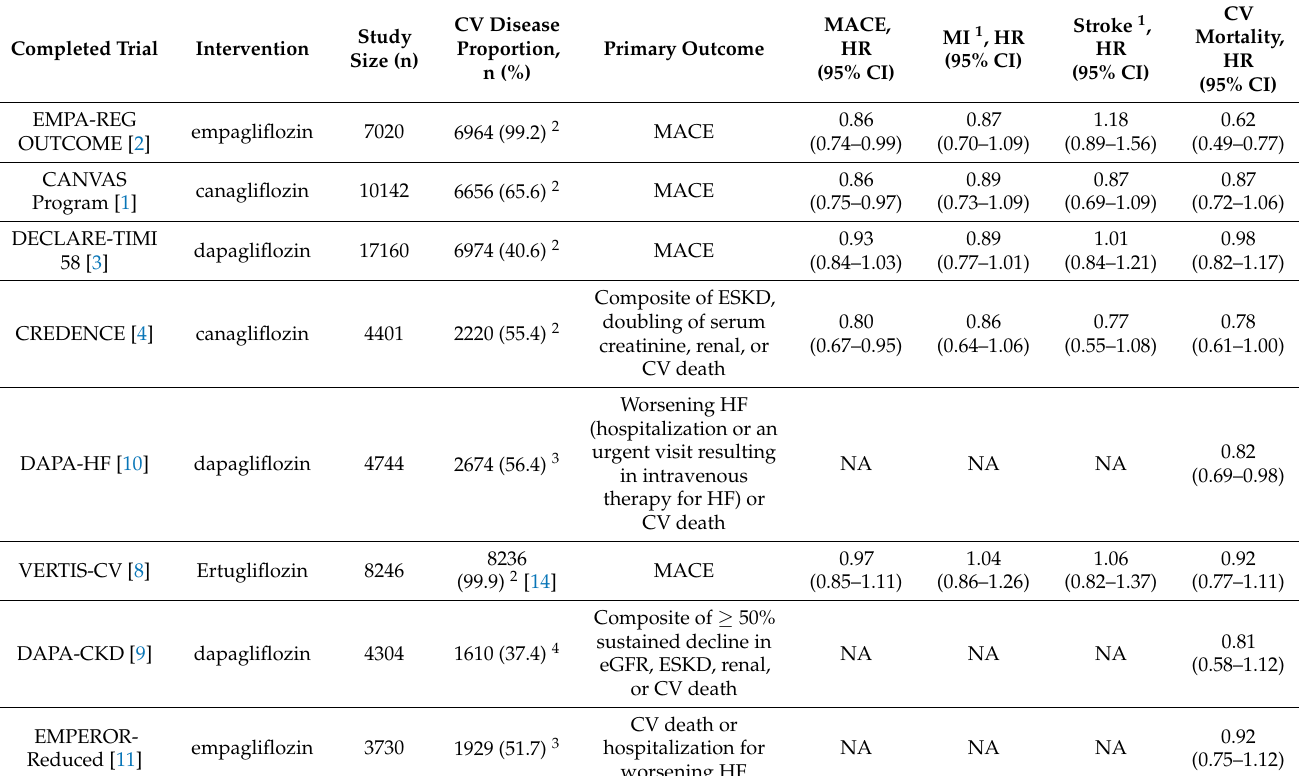
Table 1. SGLT2 inhibitors main cardiovascular outcome trials